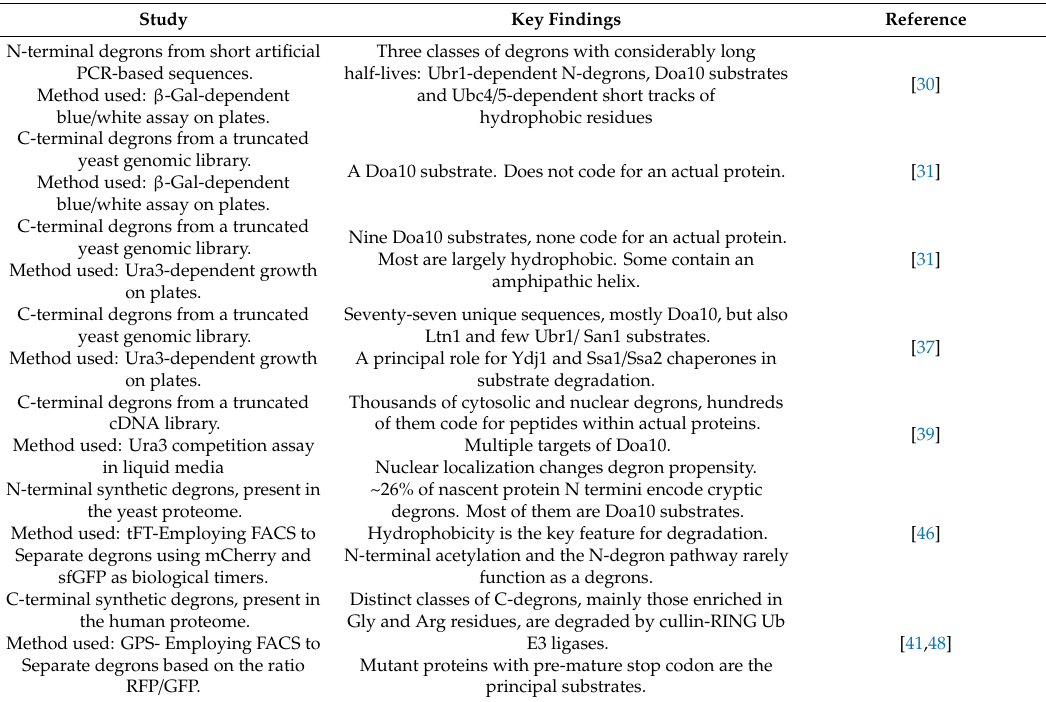
Table 1. Summary of high throughput degron